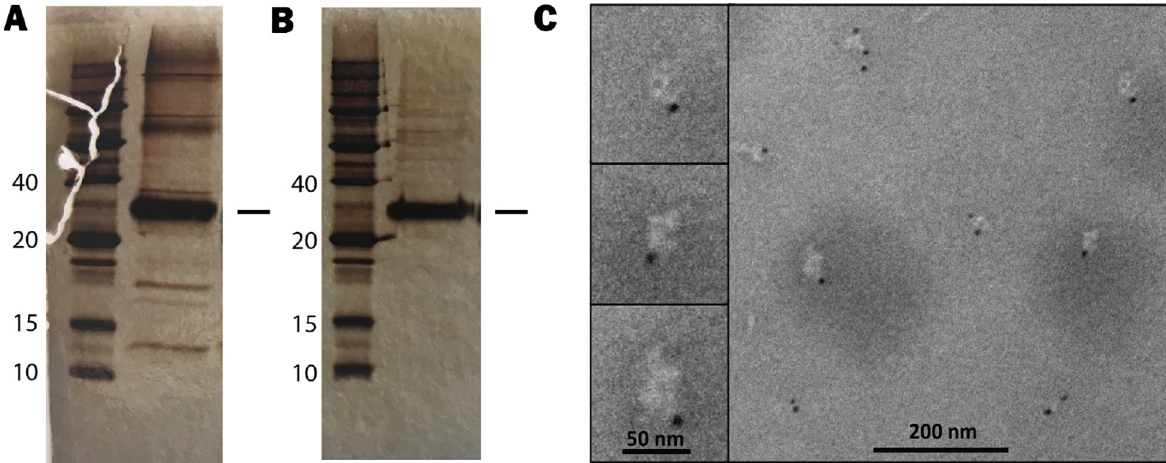
Fig 2. Recombinant MraY extracted (one-step) from B . subtilis using two different solubilization approaches. Purified MraY (indicated by a black stroke) solubilized by the detergent DDM (A) or solubilized by SMA (B). Protein bands were visualized by silver staining. (C) Transmission electron microscopy images of MraY in SMA-wrapped nanodiscs after nano-gold labeling. Three nanodiscs from the overview are shown in the enlarged images in the left panel (scale bar: 50 nm).